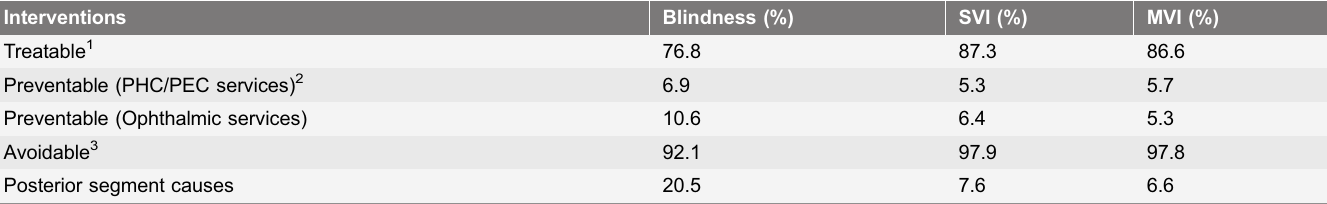
Table 6. Causes of Blindness, SVI, and MVI categorized by possible interventions. Interventions